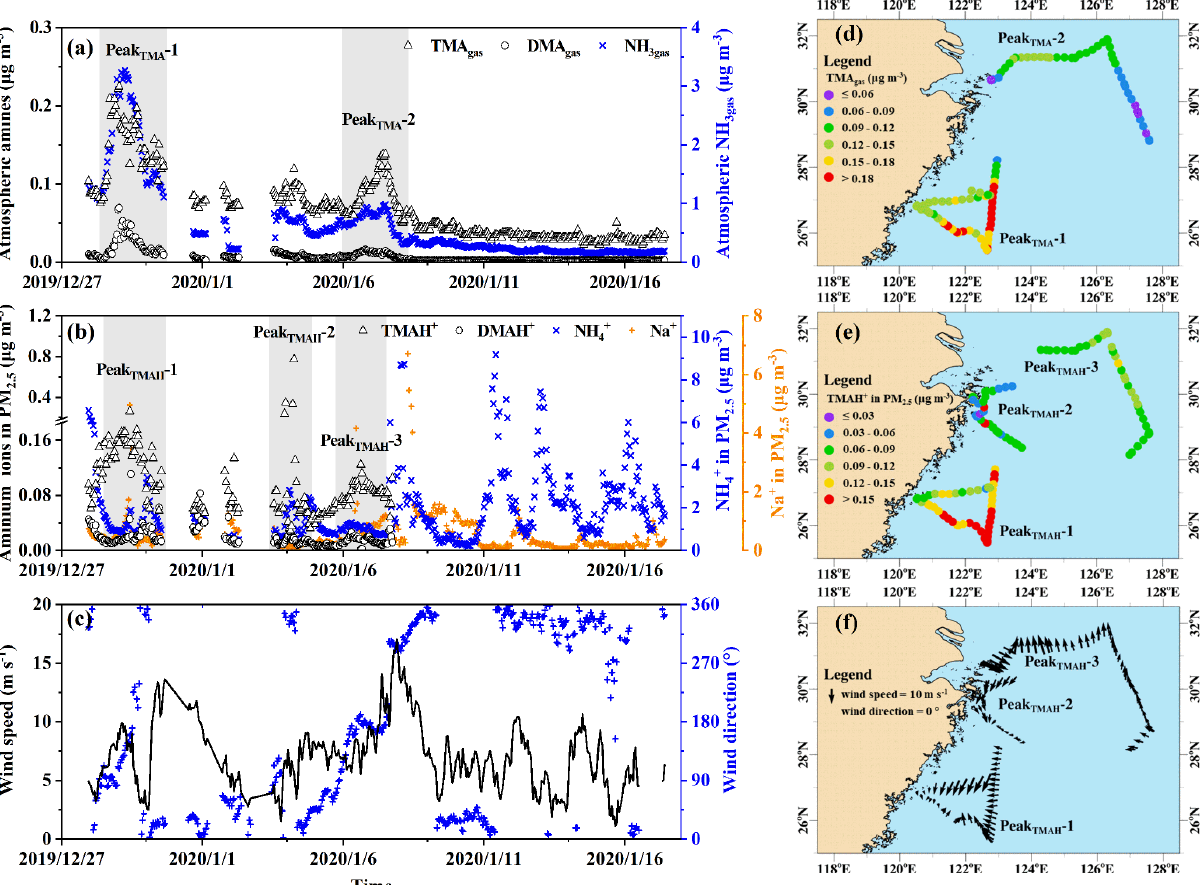
Figure 1. Time series and maps of basic gases and particulate counterparts in concentration and meteorological parameters during the cruise campaign from 27 December 2019 to 17 January 2020: time series of TMA gas , DMA gas , and NH 3gas (a) ; time series of TMAH + , DMAH + , and NH + in PM 2 . 5 (b) ; time series of wind speed and wind directions (c) ; map of TMA gas (d) ; map of TMAH + (e) ; map of wind fields (f) ; 4 not all data were shown in (d–f) to avoid